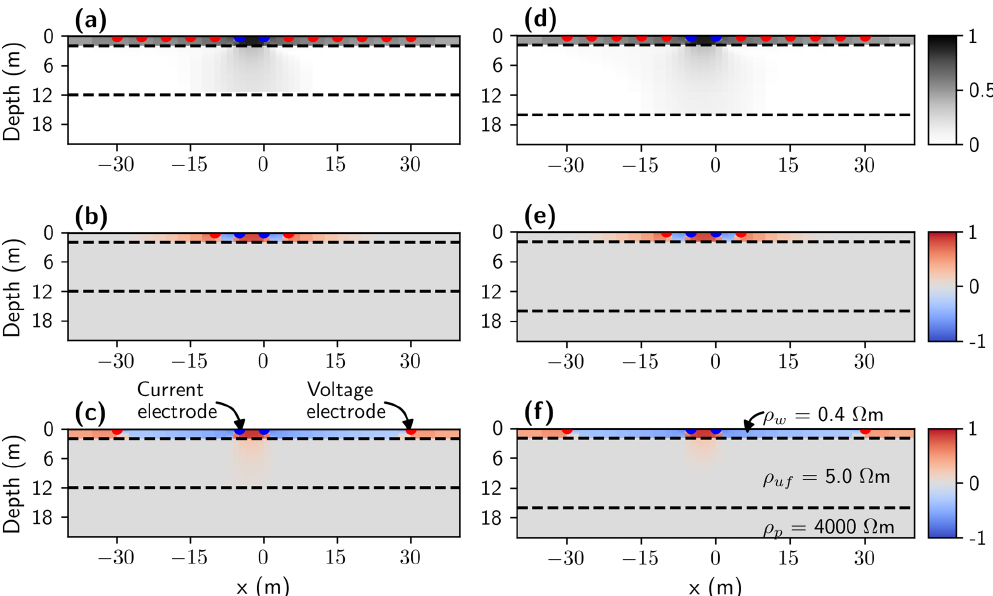
Figure 10. Two-dimensional normalized sensitivities for two different model scenarios developed for the Drew Point field site. Position of the IBPT at a depth of (a–c) 12m and (d–f) 16m. From top to bottom, we show the cumulative sensitivity and the sensitivity for the shortest and widest quadripole, respectively.